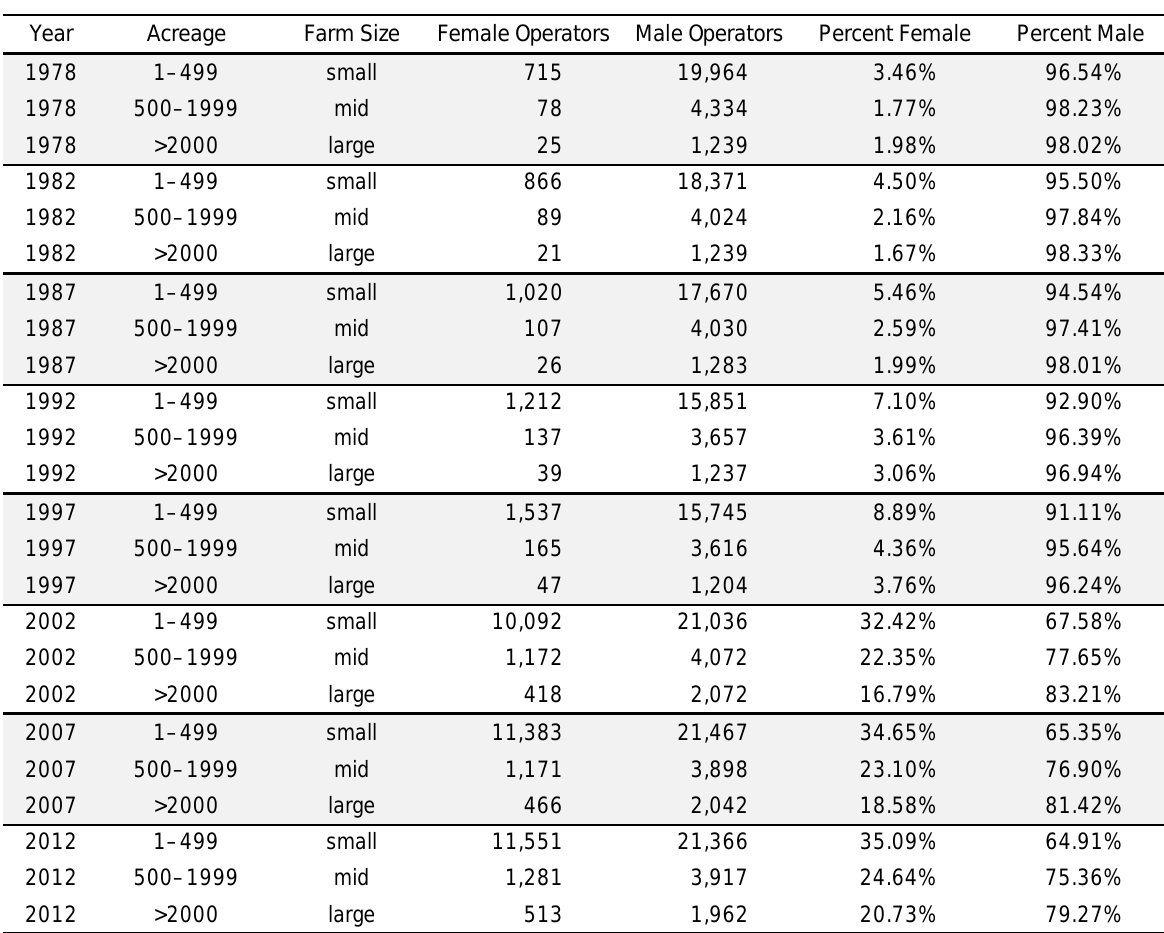
Table 1. Change in the Percentage of Female Principle Operators, by Farm Size, Reported in the Census of Agriculture,